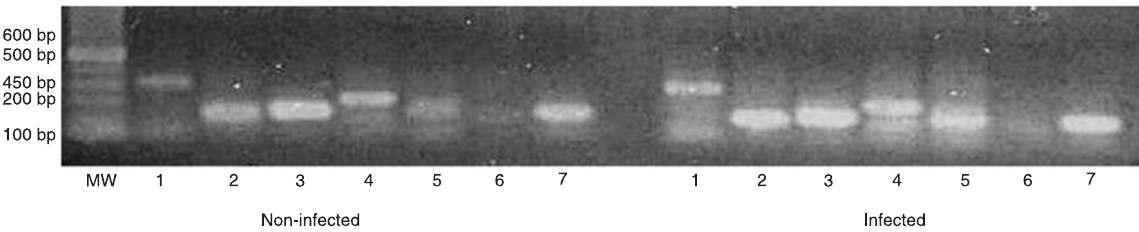
Figure 2. Detection of hamster cytokine mRNA. The mRNA of spleen cells (2 x 10 7 cells/mL) was analyzed by reverse transcriptase polymerase chain reaction (RT-PCR) for lane 1 = HPRT (420 bp), lane 2 = TNF-α (260 bp), lane 3 = TGF-β (270 bp), lane 4 = IL-2 (400 bp), lane 5 = IL-4 (290 bp), lane 6 = IL-10 (280 bp), and lane 7 = IFN-γ (320 bp) expression both in non-infected and infected-hamsters (15 days post-infection). MW = molecular weight